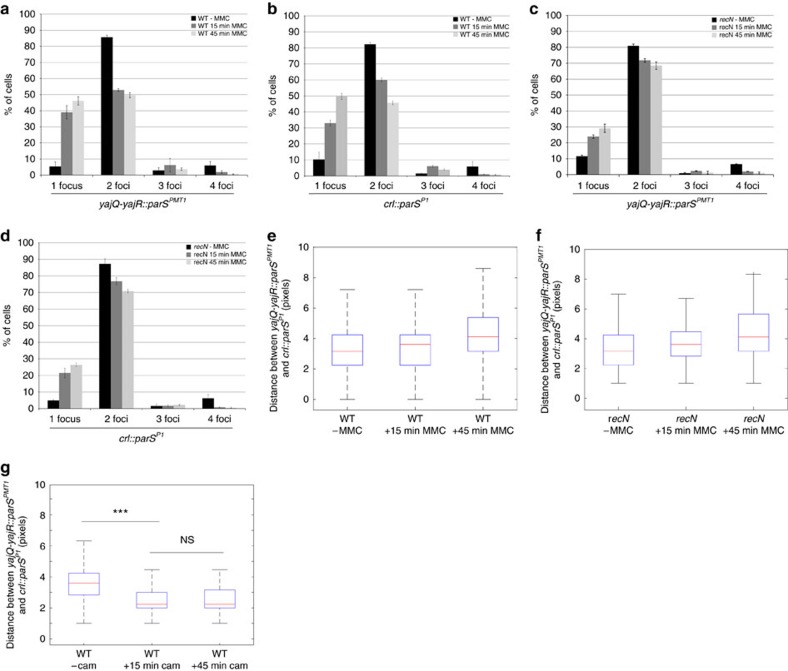
RecN influences SCC but not DNA condensation.(a) The number of foci per cell at the yajR-yajQ::parSpMT1 site was counted in cells treated with MMC for 0, 15 or 45 min. (b) The number of foci per cell at the crl::parSP1 site was counted in cells treated with MMC for 0, 15 or 45 min. (c) Same as a, but performed in the recN mutant. (d) Same as b, but performed in the recN mutant. In a–d, error bars represent standard deviations of 300 cells. (e) The distance between two loci on the same replichore of the chromosome, spaced by 188 kb and tagged with a parSP1 or a parSpMT1 site (crl::parSP1 and yajQ-yajR::parSpMT1, respectively), was measured after treatment with 10 μg ml−1 MMC for 0, 15 or 45 min. The results are shown as a box plot representing the median, first and forth quartiles (N=300). (f) Same as e, but performed in the recN mutant. (g) The distance between two loci on the same replichore of the chromosome, spaced by 188 kb and tagged with a parSP1 or a parSpMT1 site (crl::parSP1 and yajQ-yajR::parSpMT1, respectively), was measured after treatment with 30 μg ml−1 of chloramphénicol for 0, 15 or 45 min. (t-test ***P<10−30, NS (not significant) P>10−5).